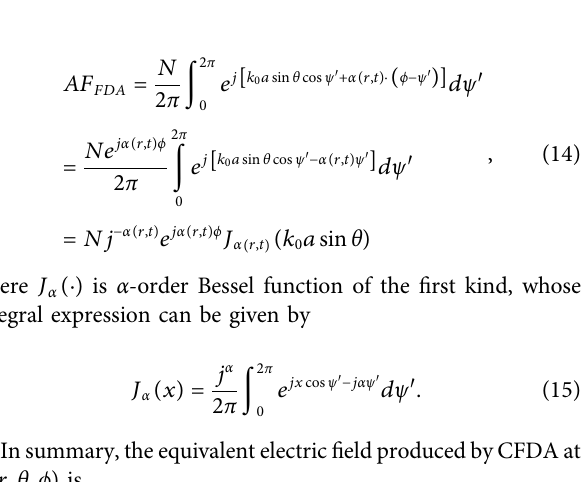
FIGURE 3 | Beam distribution and phase distribution of the CFDA-based OAM at different times while z = 2.5 m . (A) Beam distribution while t = 12.5 ns ; (B) phase distribution while t = 12.5 ns ; (C) beam distribution while t = 14.583 ns ; (D) phase distribution while t = 14.583 ns ; (E) beam distribution while t = 16.667 ns ; and (F) phase distribution while t = 16.667 ns